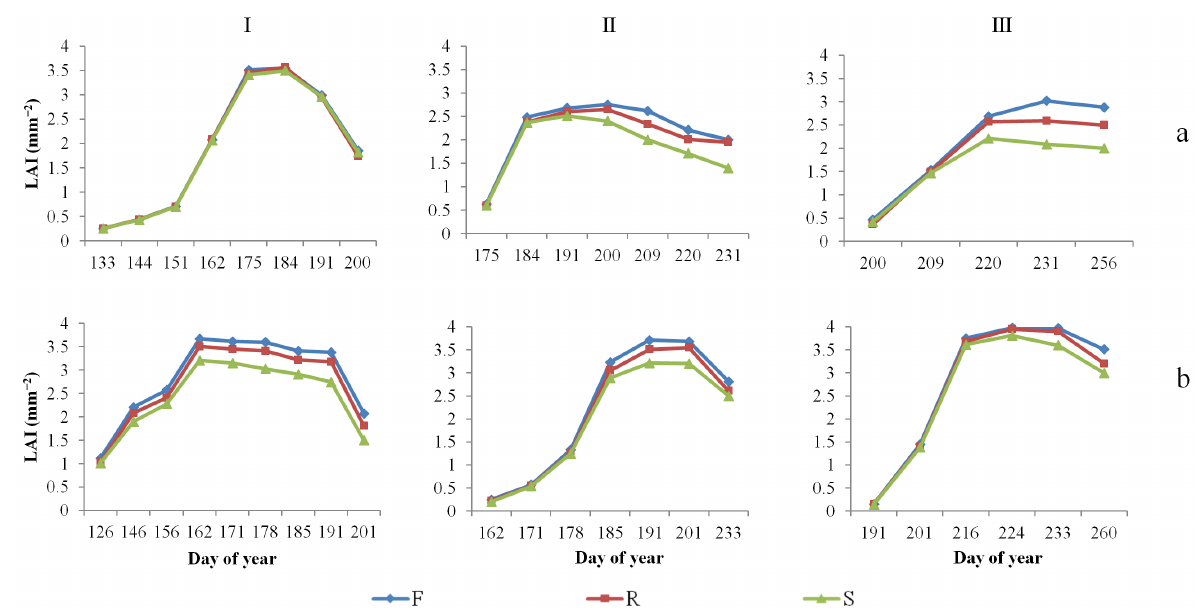
Figure 9. Leaf area index (LAI) by irrigation treatments (F, R and S) and sowing periods (I, II, and III) in 2019 ( a ) and 2020 ( b ).